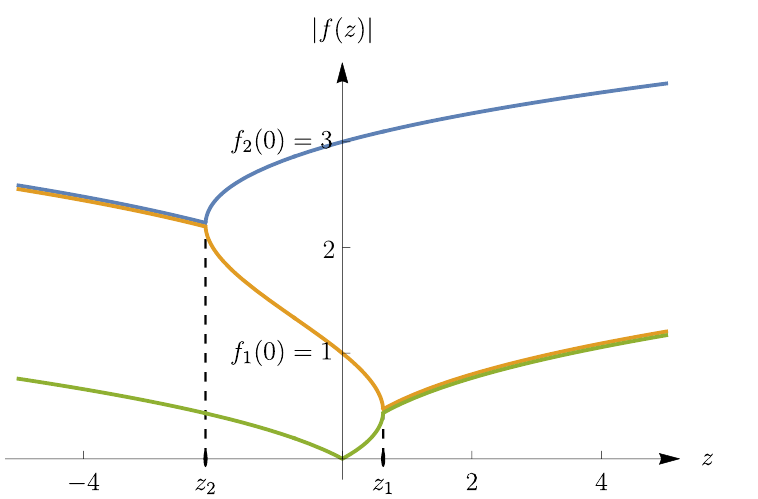
Figure 2. Absolute values of the solutions f 0 ( z ) (in green), f 1 ( z ) (in orange) and f 2 ( z ) (in blue) to eq. (4.1) plotted for real z . The two real critical points are labeled by z 1 and z 2 (cf. eq.